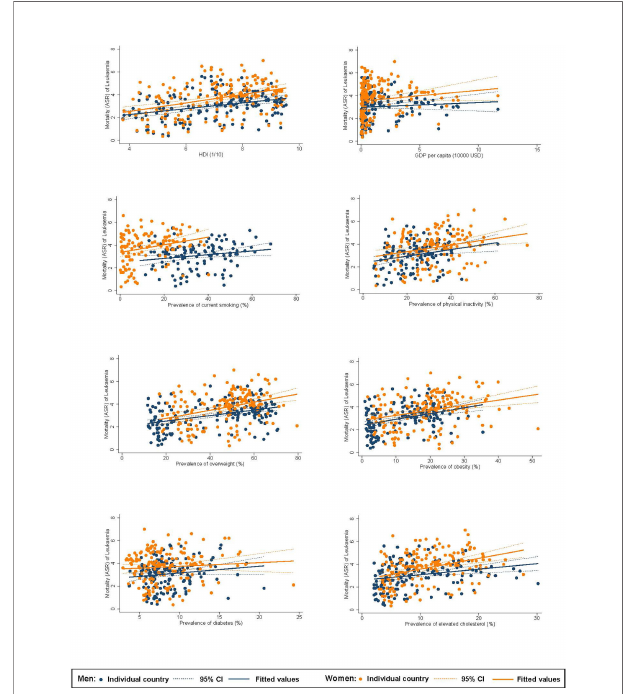
FIGURE 3 | Associations between risk factors and mortality of